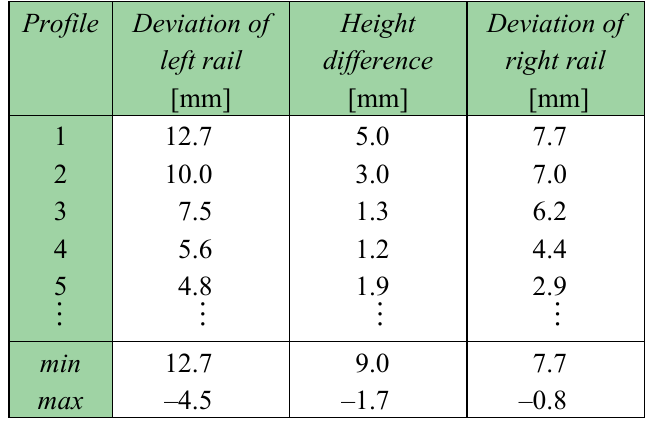
Table 6. Representation of numerical results of surveying in vertical direction.